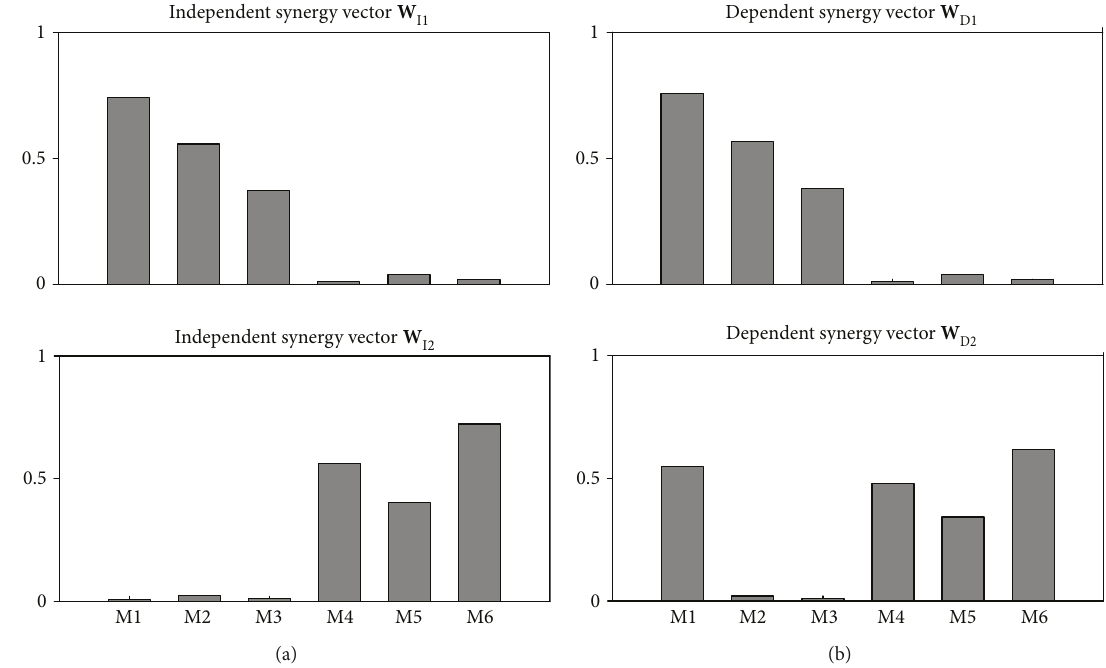
fi cantly contributes to only I , in which each muscle signi